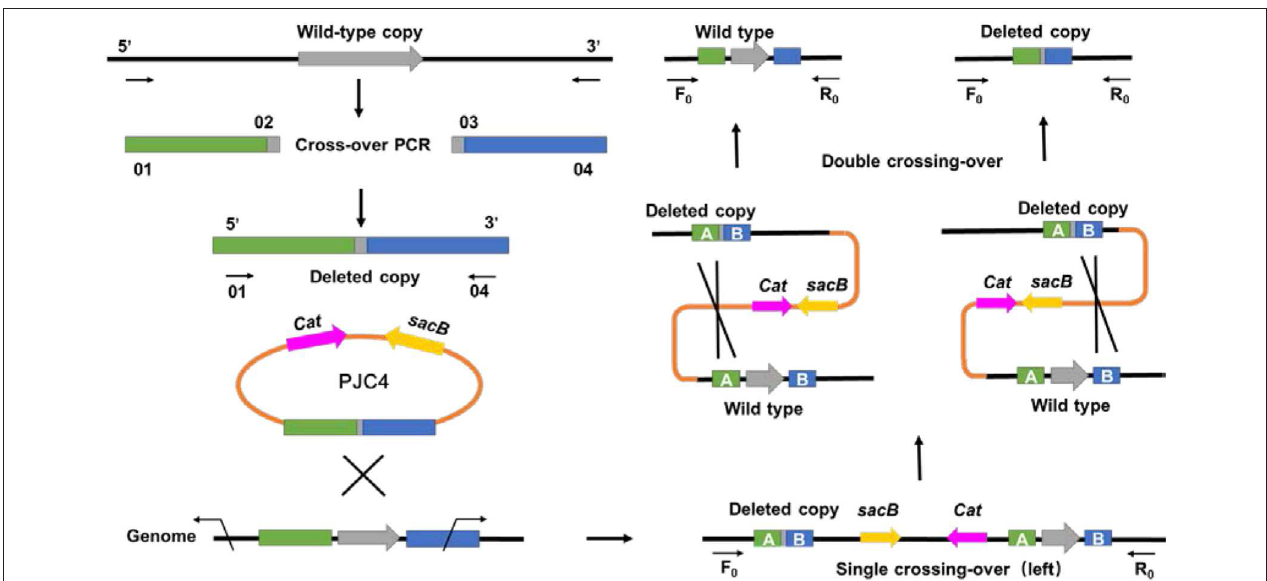
FIGURE 1 | General diagram representing an alternative method for markerless gene deletion by allelic exchange in Actinobacillus succinogenes .